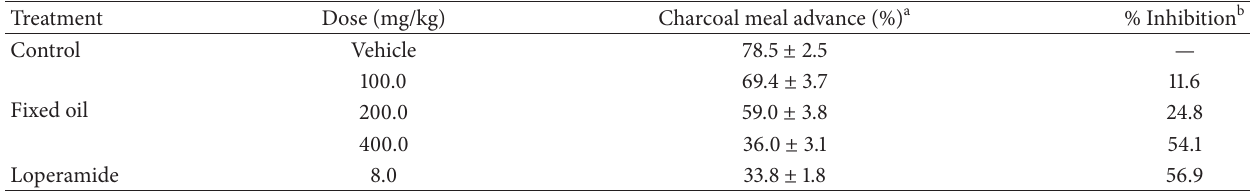
Table 4: Effect of orally administered fixed oil of Annona muricata L. seeds on gastrointestinal transit in